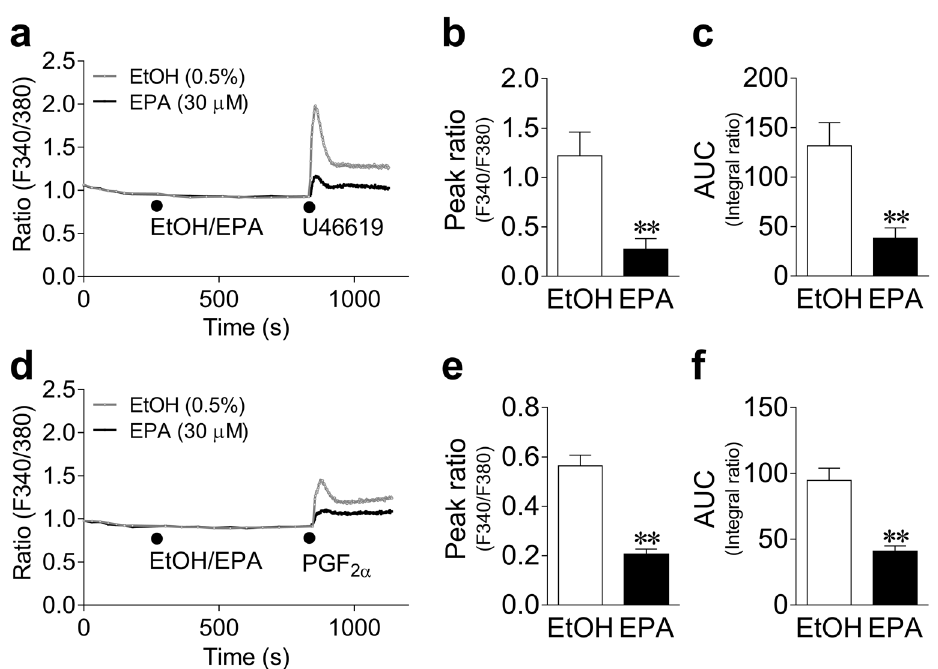
Figure 5. Changes in Fura-2 (an intracellular Ca 2+ indicator) fluorescence intensity ratio at 510 nm elicited by 340/380 nm excitation (F340/380) induced by 10 nM U46619 ( a ) and 3 μM prostaglandin (PG) F 2α ( d ) in the presence of 30 μM eicosapentaenoic acid (EPA) or 0.5% ethanol (EtOH) in cells expressing the human prostanoid TP receptor; quantified data of the F340/380 peak after application of U46619 ( b ) or PGF 2α ( e ) and the F340/380 integral (area under the curve, AUC) within 5 min of application of U46619 ( c ) or PGF 2α ( f ). Changes in F340/380 are presented as means only, and quantified data are presented as mean ± SEM (each n = 10). ● : each drug application. **P < 0.01 versus EtOH (Student’s t